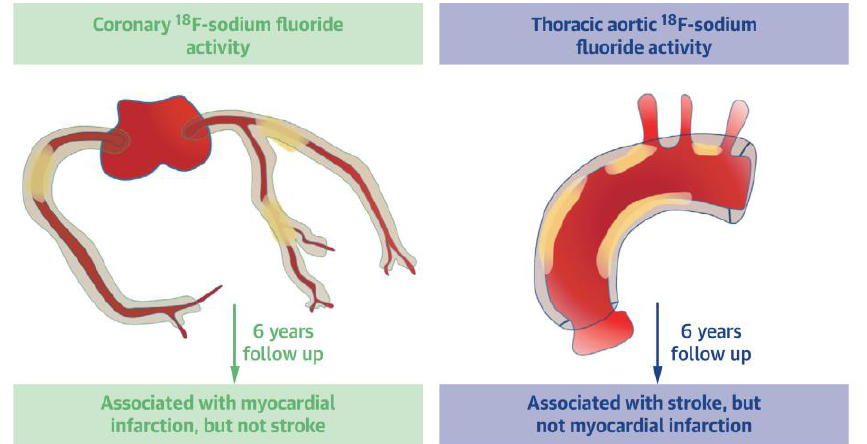
Figure 4. Schematic representation of measurement NaF uptake and calculation of coronary micro- calcification score (left) and arch of the aorta NaF activity (right). Reproduced from Fletcher, A.J et al. [40], an open access article under the CC BY license.